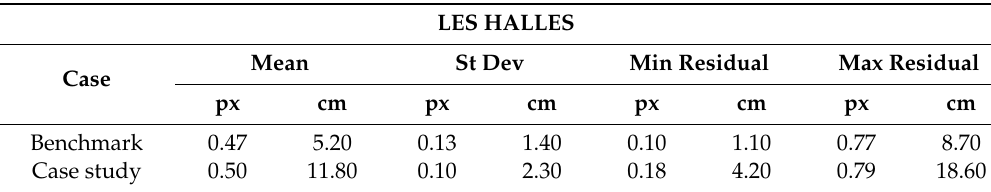
Table 9. Mean, standard deviation, Min and Max values of residuals.